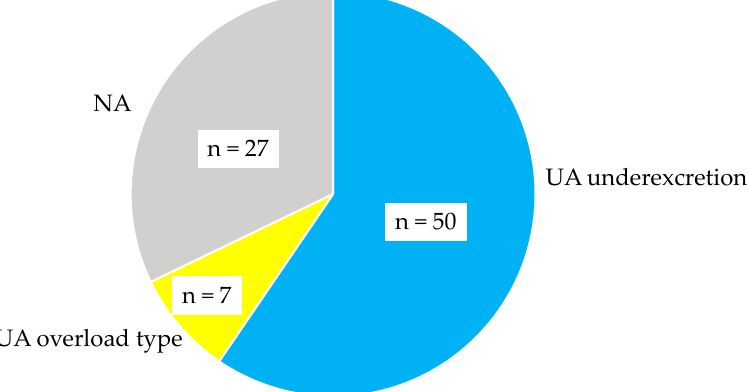
The proportion of hyperuricemia phenotype in our patients were shown in Figure 2. Among patients whose urinary UA/creatinine were measured, almost 88% patients were UA underexcretion type, and the proportion of patients with renal UA overload type was only 12%.